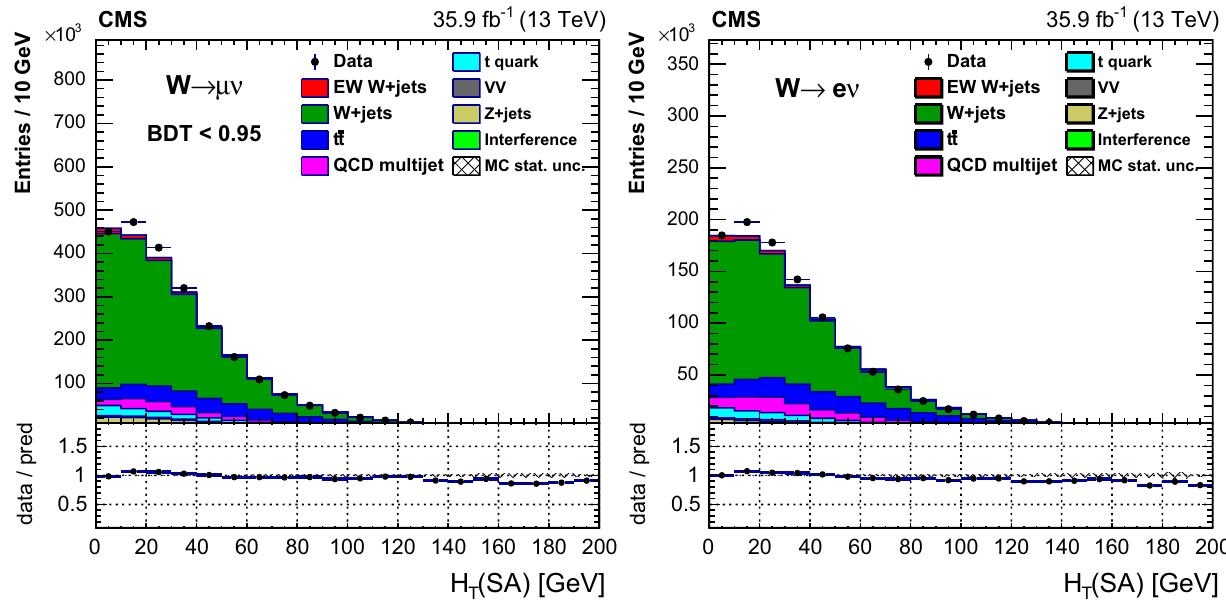
Fig. 26 Total soft activity (SA) jet H T for BDT < 0 . 95 in the muon (left) and electron (right)